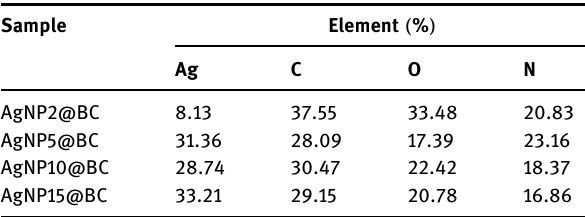
Table 1: Elements detected in AgNPs templated BC samples by EDX